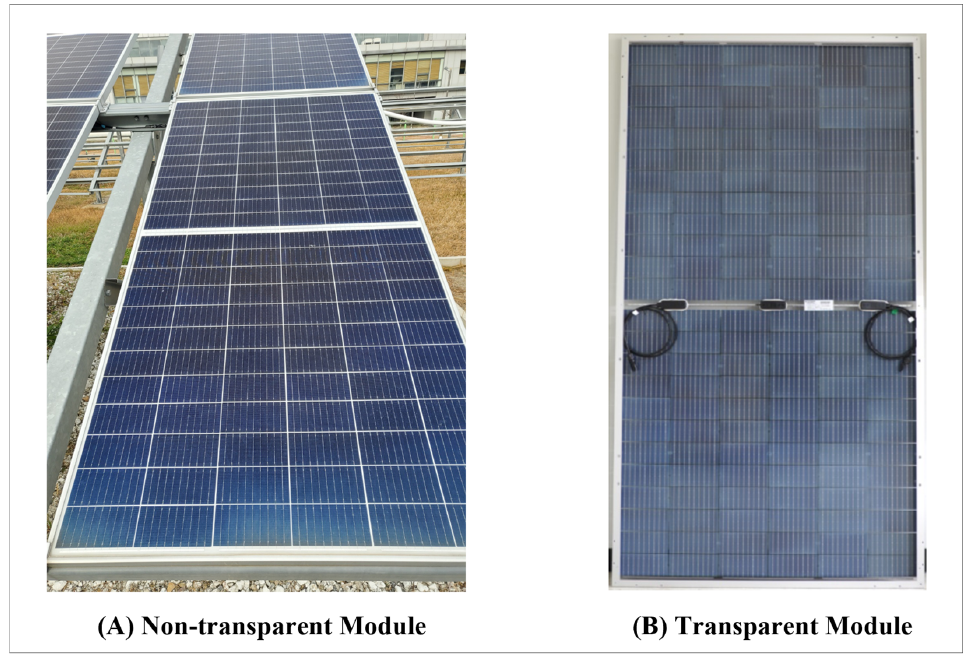
Figure 1 . Real photographs of (A) Non-transparent and (B) Transparent Photovoltaic Modules. Figure 1. Real photographs of ( A ) Non-transparent and ( B ) Transparent Photovoltaic Modules. Table 1. Physical characteristics of PV